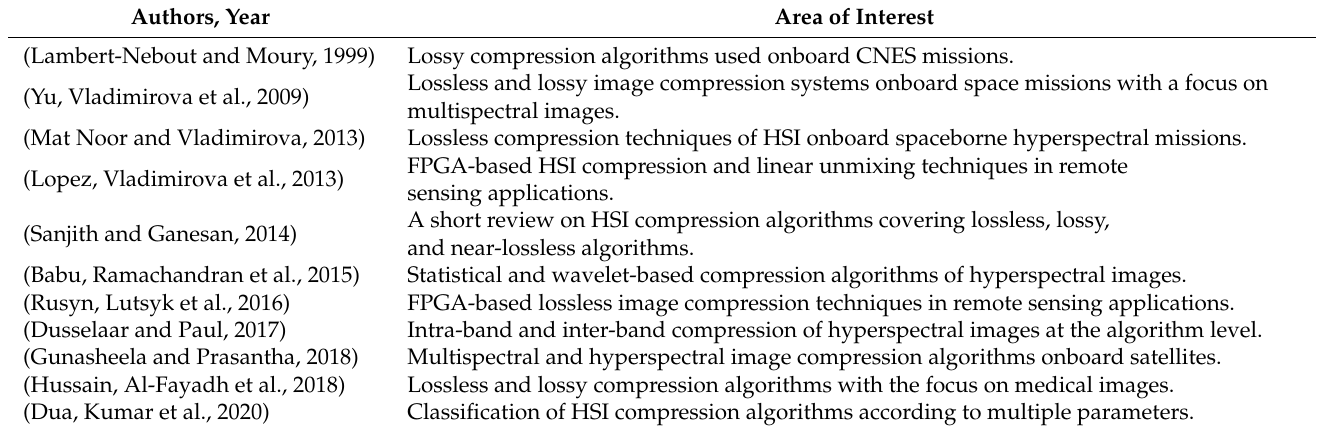
Table 1. The areas of interest covered by related reviews on HSI image compression algorithms. Area of Interest Lossy compression algorithms used onboard CNES missions. Lossless and lossy image compression systems onboard space missions with a focus on multispectral images. Lossless compression techniques of HSI onboard spaceborne hyperspectral